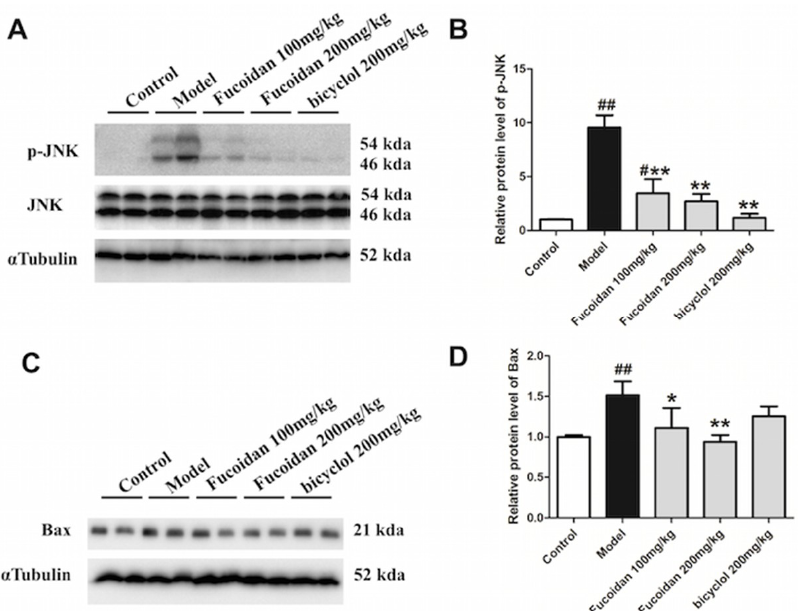
Figure 3. Fucoidan inhibited APAP-induced c-Jun N-terminal protein kinase (JNK) phosphorylation and Bax protein expression in mice. Male ICR mice were randomly divided into control, model, fucoidan 100 mg/kg, fucoidan 200 mg/kg, and bicyclol 200 mg/kg groups. After pretreating with fucoidan or bicyclol for 7 days, the acute hepatic injury model was induced by intraperitoneal injection of 500 mg/kg APAP, and the normal group was injected with an equal amount of saline. Four hours after injection, the hepatic tissue was taken for further detections. The ( A , B ) phosphorylation level of JNK and ( C , D ) protein expression of Bax were determined by Western blotting analysis. The quantification of relative protein expression was performed by densitometric analysis, and α Tubulin was used as an internal control. All results were expressed as mean ± SD, n = 6, # p < 0.05, ## p < 0.01 versus control group; * p < 0.05, ** p < 0.01 versus model group.